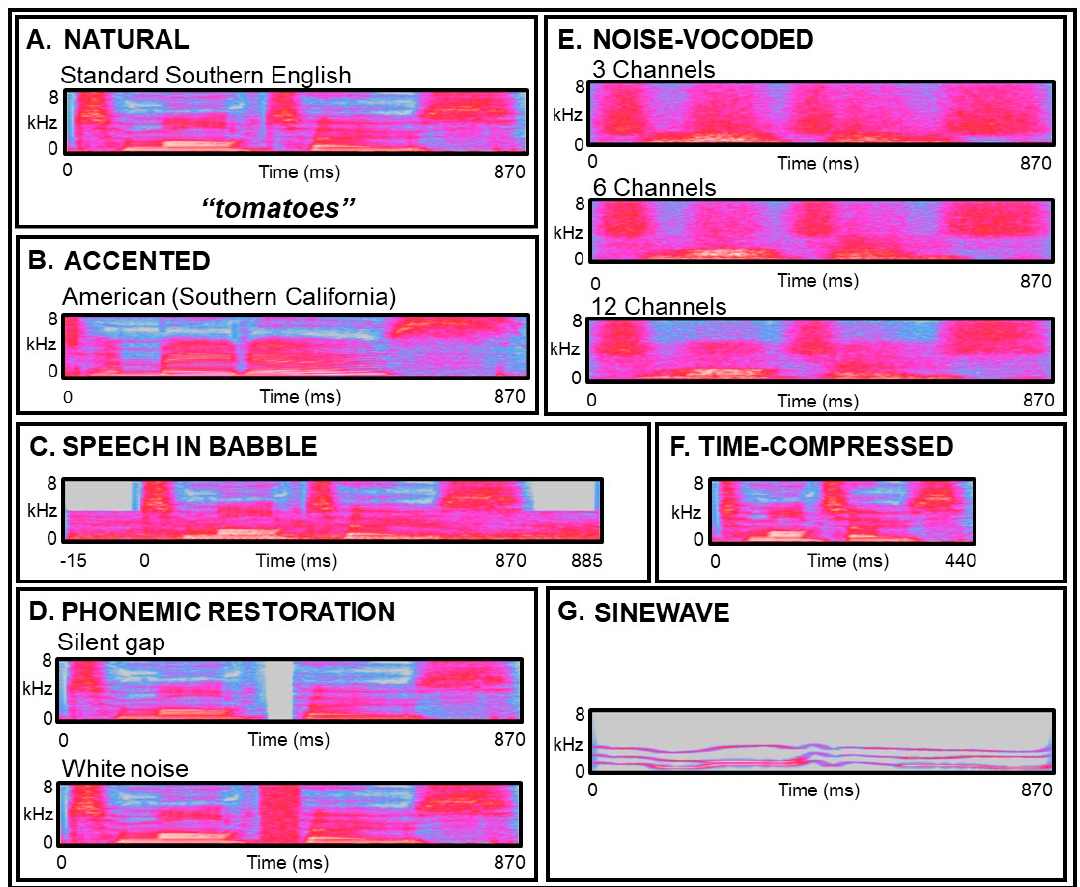
Figure 2. Examples of degraded speech manipulations used experimentally and their acoustic effects on the speech signal. Broadband time-frequency spectrograms of the same speech token (“tomatoes”), subjected to different forms of speech degradation (all samples apart from 2B were recorded by a native British speaker with a Standard Southern English accent; wavefiles of A–G are in Supplementary Material online). ( A ) Natural speech token. ( B ) Same speech token spoken with an American-Californian accent (an accent is a meta-linguistic feature that reveals information about the speaker’s geographical or socio-cultural background [53]; normal listeners make predictions about speakers’ accents that tend to facilitate faster accent processing [54]). ( C ) Speech in multi-talker babble (speech-in-noise can be adaptively adjusted to find the point at which speech switches from intelligible to unintelligible [55]; background “noise” used experimentally typically comprises either “energetic” masking (e.g., steady-state white noise) or “informational” masking (e.g., multi-talker babble, as illustrated here)) [56], ( D ) Perceptual (or phonemic) restoration (Warren [57] originally observed that when a key phoneme is artificially excised from a given sentence, control participants are unable to identify the location of the missing phoneme when “filled-in” with a burst of white noise (bottom panel), but are able to identify the location accurately if the gap remains silent (top panel), i.e., they perceptually “restore” the excised phoneme). ( E ) Noise-vocoded speech (vocoding removes fine spectral detail from speech, whilst preserving temporal cues [58,59]; three bands of modulated noise (i.e., three “channels”; top panel) are the minimum needed for consistent recognition by normal listeners [59], spectrograms for six (middle panel) and twelve (bottom panel) channels also shown here). ( F ) Time-compressed speech (created by artificially increasing the rate at which a recorded speech stimulus is presented; intelligibility decreases as speech compression rate increases [60–62]). ( G ) Sinewave speech (this transformation reduces speech to a series of “whistles” or sinewave tones that track formant contours [63]). Note that these speech manipulations vary widely in the cognitive process they target, the degree to which they degrade the speech signal and their ecological resonance (see also Table 1); accented speech and speech-in-noise or babble are commonly encountered in daily life through exposure to diverse speakers and noisy environments, perceptual restoration simulates the frequent everyday phenomenon of speech interruption by intermittent extraneous sounds (e.g., a slamming door), whereas sinewave-speech is a drastic impoverishment of the speech signal that sounds highly unnatural but becomes intelligible with exposure due to perceptual learning